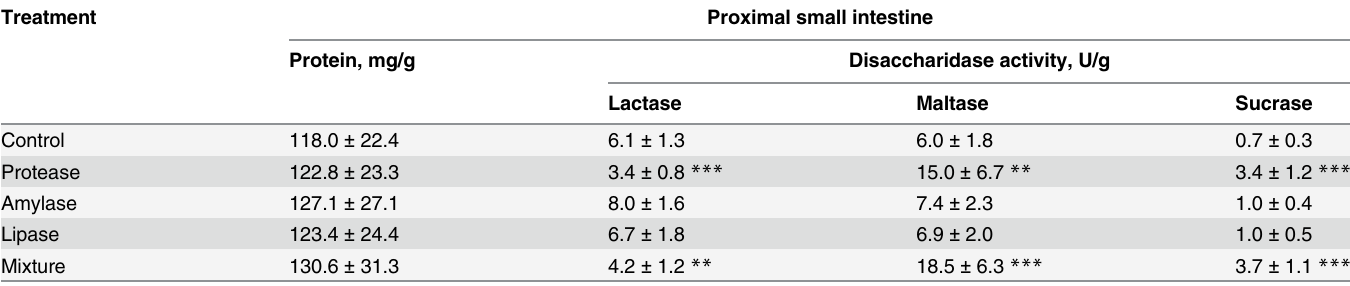
Table 3. Intestinal mucosal disaccharidase activities of 17 d-old rats after gavage feeding with microbial-derived enzymes, i . e ., a protease, amylase, lipase, and a mixture thereof, or water (control) during 14 – 16 days of age. Treatment